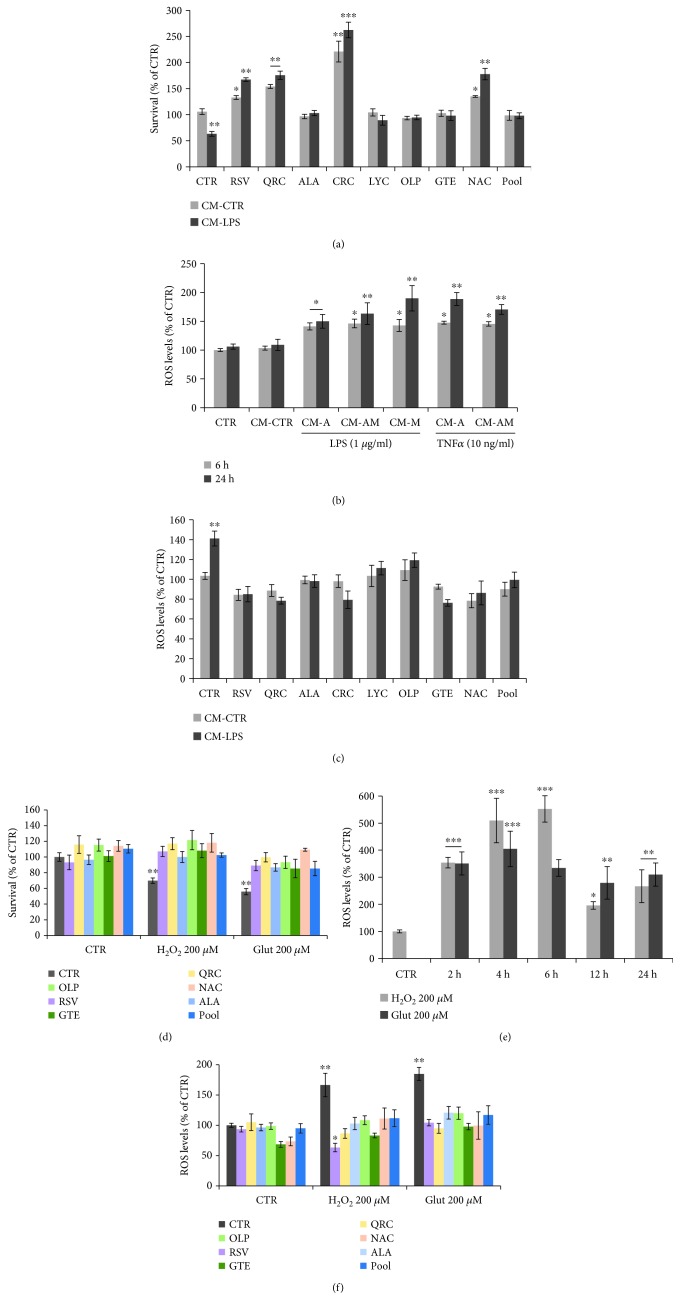
Effect of antioxidant molecules on neuronal ROS levels and survival. (a) MTT assay of cortical neurons exposed for 24 h to CM-LPS from LPS-stimulated astrocytes. Where indicated, neurons were preincubated ON with RSV (10 μM), QRC (10 μM), ALA (10 μM), CRC (10 μM), LYC (10 μM), OLP (100 μg/ml), GTE (12.5 μg/ml), NAC (300 μM), or pool-R. (b) Quantitation of neuronal ROS levels by FACS analysis of DCH2F-DA fluorescence following exposure to CM from LPS- or TNFα-stimulated astrocytes for 6 or 24 h. (c) Neuronal ROS levels following a 6 h treatment with CM-LPS. Where indicated, neurons were preincubated with the indicated antioxidants or the pool. (d) Survival of cortical neurons following 12 h treatment with H2O2 (200 μM) or Glut (200 μM), in the presence/absence of the indicated antioxidants or the lower concentration pool. (e) Time course of neuronal ROS production during incubation with H2O2 (200 μM) or Glut (200 μM). (f) Neuronal ROS levels following treatment with H2O2 (200 μM) or Glut (200 μM). Where indicated, neurons were preincubated with the indicated antioxidants or the pool. Data are expressed as percent of CTR. MTT data are the mean ± SEM of three independent experiments, each performed with 4-6 samples for each treatment. ROS data are the mean ± SEM of three experiments in duplicate. ∗p ≤ 0.05, ∗∗p ≤ 0.01, and ∗∗∗p ≤ 0.001 versus CTR (ANOVA and Dunnett's multiple comparison test).